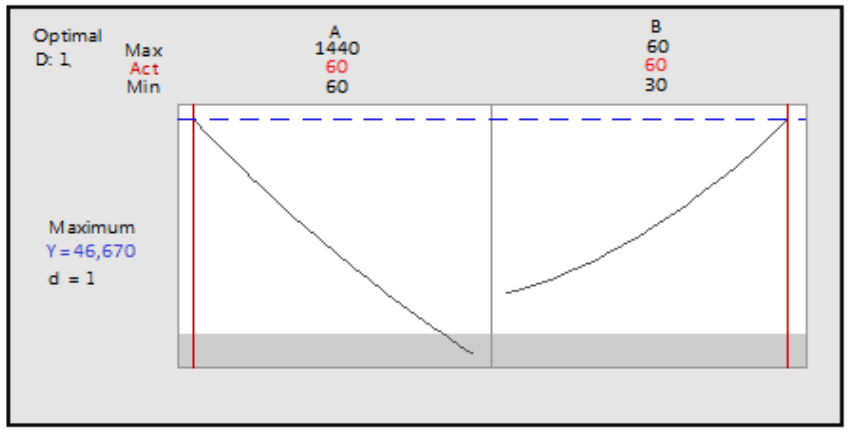
Figure 6. Optimization of the two factors maceration time and ultrasonication time as a function of desirability; A: maceration time; B: ultrasonication time. Table 2. Confirmation results of the model with the measured values and the predicted values of the studied responses.